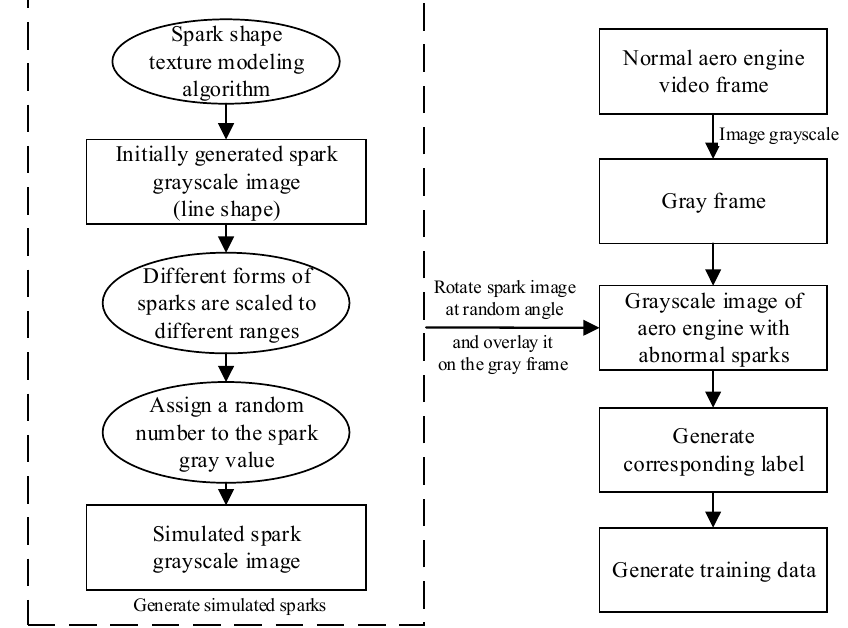
Figure 12. Flow chart of generating training data.